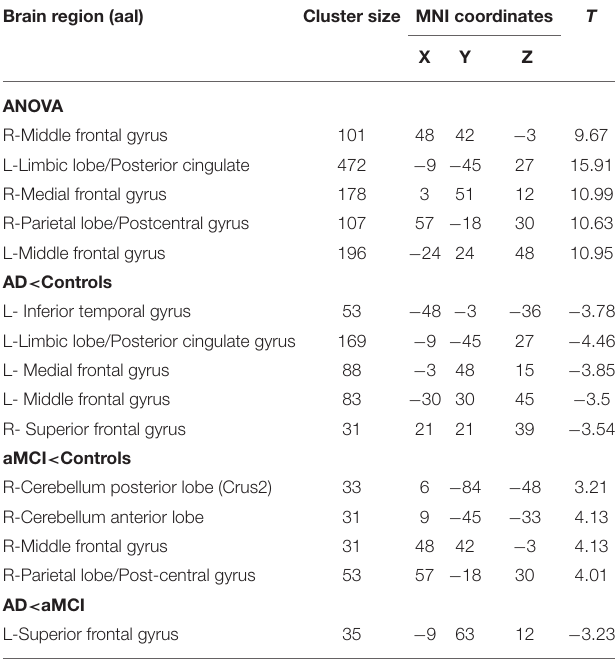
Frontiers in Neurology |